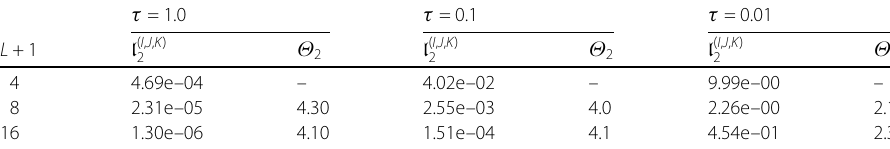
Table 1f Errors and order for UM-FOCS in Example 5.1